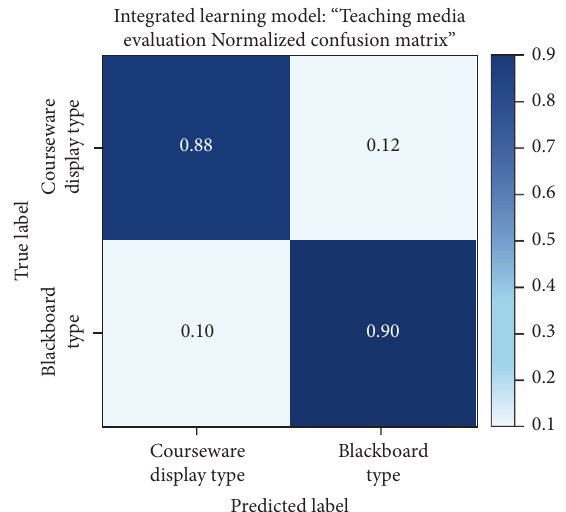
Figure 6: Integrated learning model: display of evaluation per- formance of “teaching media evaluation”